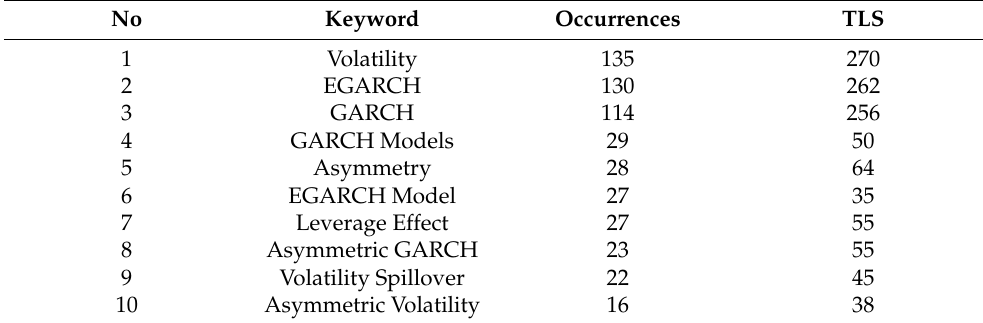
Table 5. Co ‐ occurrence of author keyword.